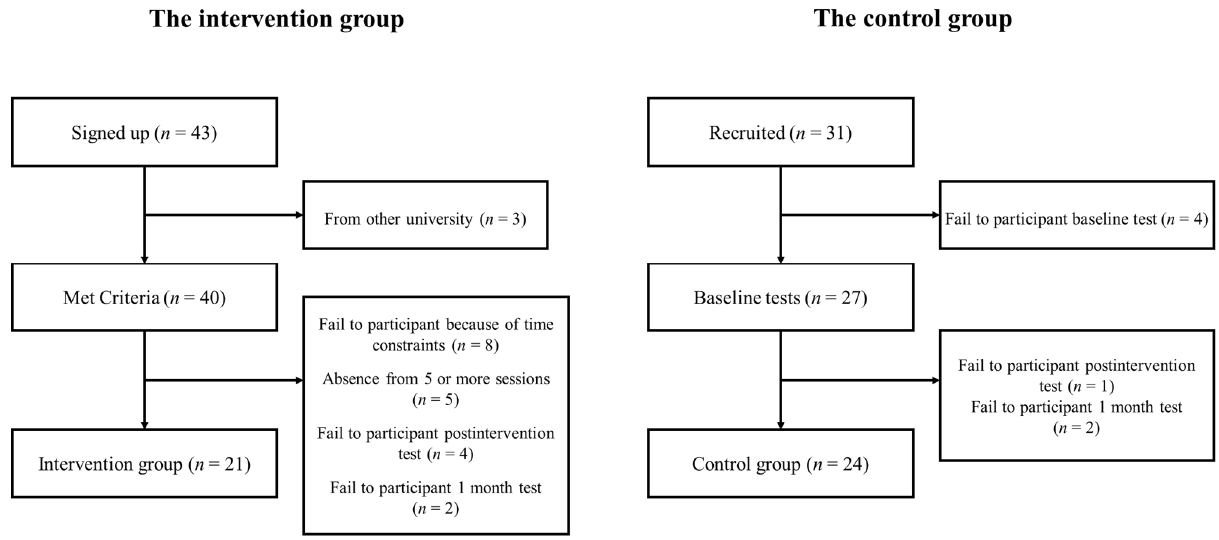
Figure 1. Flow diagram for enrollment.